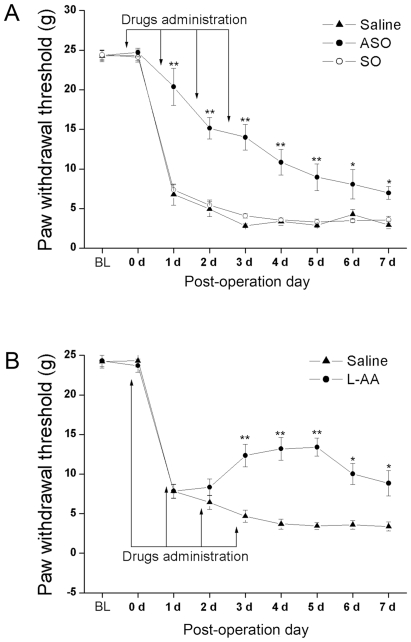
Effects of intrathecal administration of c-fos ASO (A) or L-AA (B) on SNL-induced mechanical allodynia.A, SNL rats in saline and c-fos SO group demonstrated significant ipsilateral allodynia since 1 d after the surgery. Intrathecal administration of c-fos ASO (50 µg/10 µl, starting 4 h prior to the surgery and once a day for a further 3 d following surgery) significantly reversed the ipsilateral allodynia. The preventing effect of ASO weakened gradually but still significant 7 d after SNL B, Intrathecal administration of astroglial toxin L-AA (100 nmol/10 µl, injected daily from 1 d before till 3 d after the surgery) reversed mechanical allodynia only at the late stage. The data are presented as the mean ± S.E.M. * and ** indicate statistically significant difference with P<0.05 and P<0.01 compared to saline control of each time point, respectively.